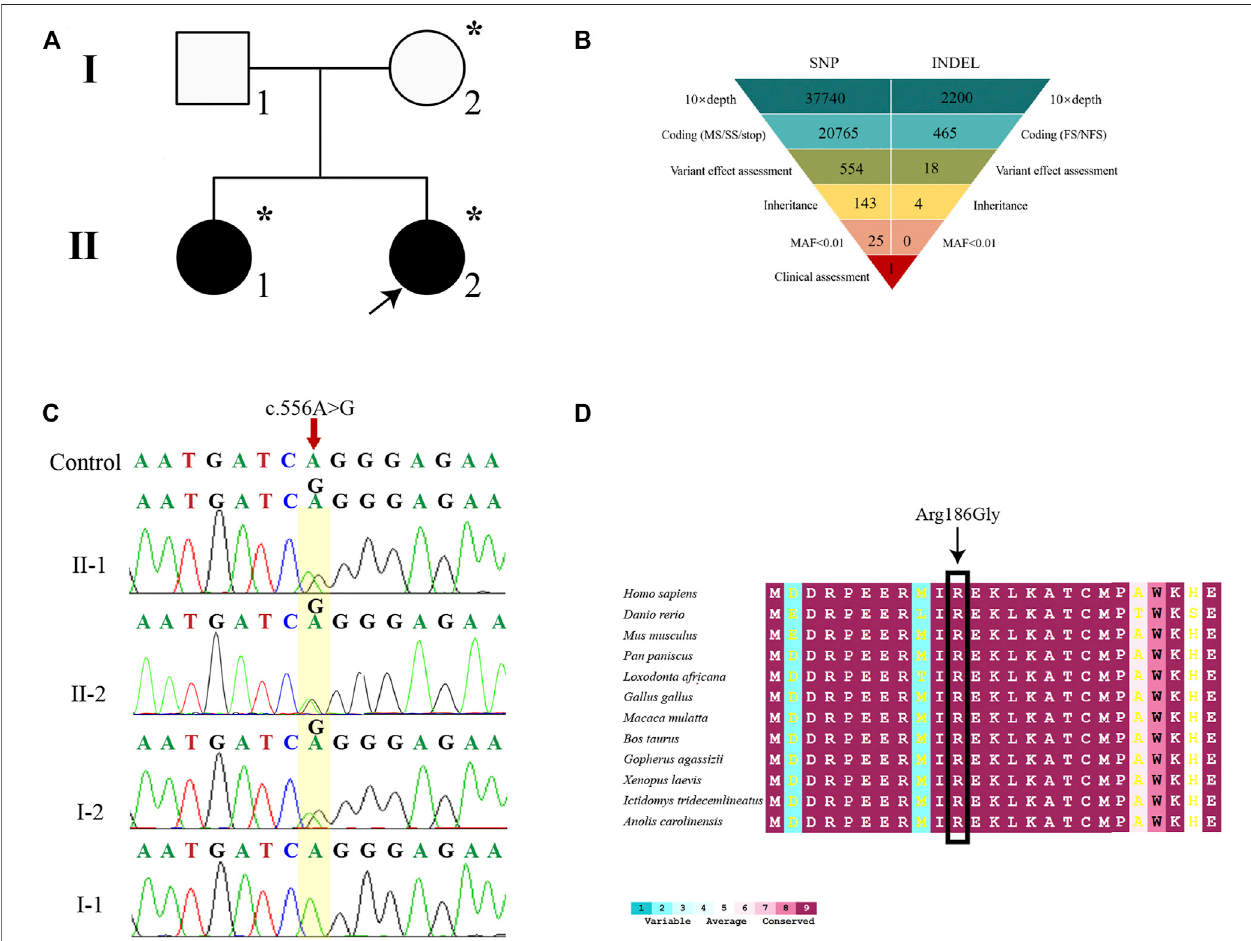
FIGURE2| Geneticdiagnosis. (A) Thepedigreewith46,XYDSD.Thearrowheaddenotestheproband.SquaresrepresentXYindividuals,andcirclesrepresentXX individuals. Affected individuals are shown as fi lled with black symbols. Dot- fi lled symbols represent the unaffected heterozygous carriers. Un fi lled symbols indicate clinicallyunaffectedsubjectsexhibitingthewild-typesequence. (B) Schematicrepresentationoftheexome-data- fi lteringapproachassumesdominantinheritanceinthe family.Thefollowingabbreviationswereused:MS,missensevariant;SS,splice-sitevariant;stop,stop-codonvariant;FS,frameshiftindel;andNFS,non-frameshift indel. (C) Sanger sequencing chromatograms is showing that the proband, her elder sister (II-1), and her mother (I-2) harbor a heterozygous c.556A > G variant of the MAP3K1 gene. (D) Inter-speci fi c conservation analysis of MAP3K1 protein. Color code bars are used to show the conservation of amino acids.